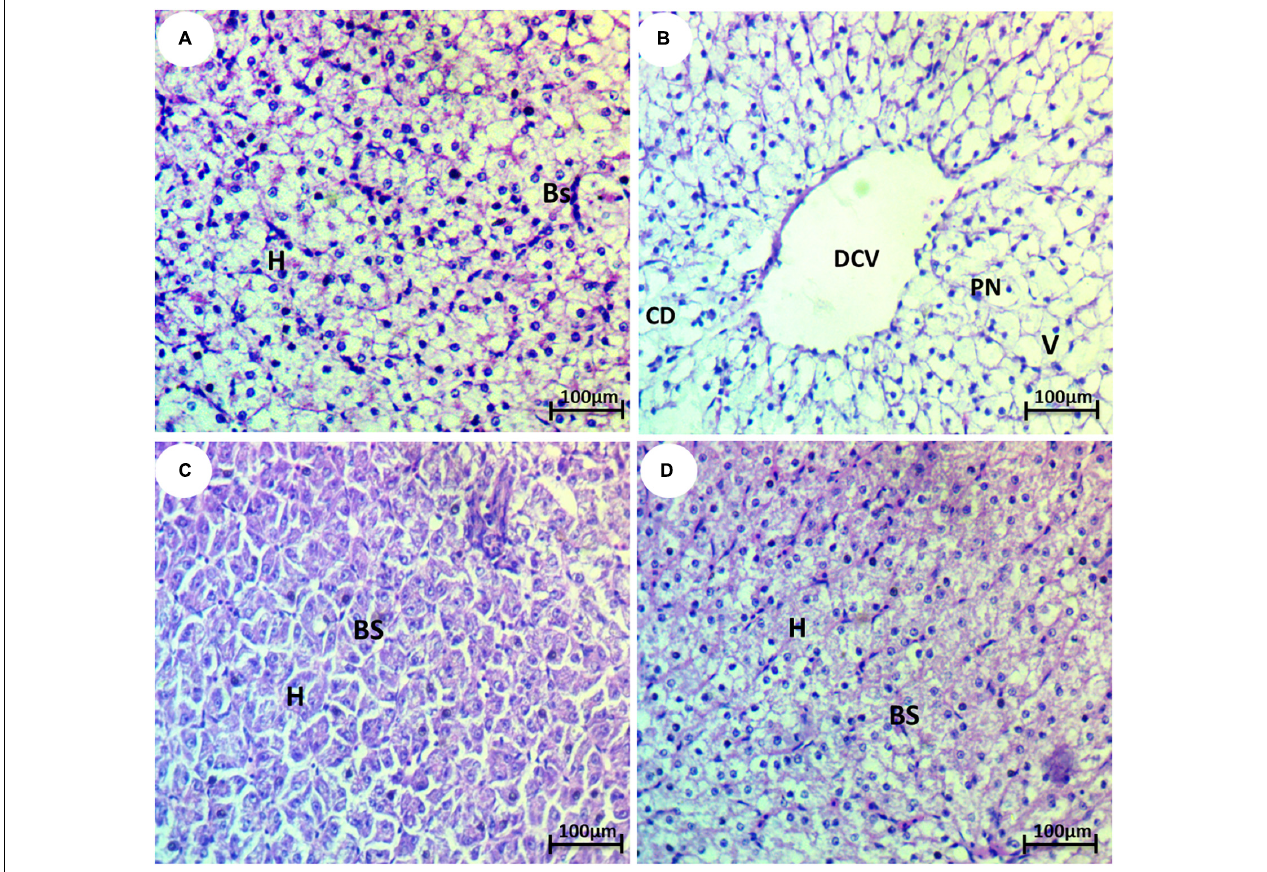
FIGURE 3 | Photomicrograph of liver tissue of the African catfish ( Clarias gariepinus ) showing (A) normal architecture of liver hepatocytes (H) and normal blood sinusoids (BS); (B) fish exposed to hydroxychloroquine showing complete degeneration (CD), pyknosis of nuclei (PN), dilation of the central vein (DCV), and vacuolization (V); (C) fish exposed to hydroxychloroquine + 10 mg/l Spirulina showing mild improvement of hepatocytes (H) and blood sinusoids (BS); and (D) fish exposed to hydroxychloroquine + 20 mg/l Spirulina showing strong improvement of hepatocytes (H) and blood sinusoids (BS) (H&E stain, scale bar 50 µ